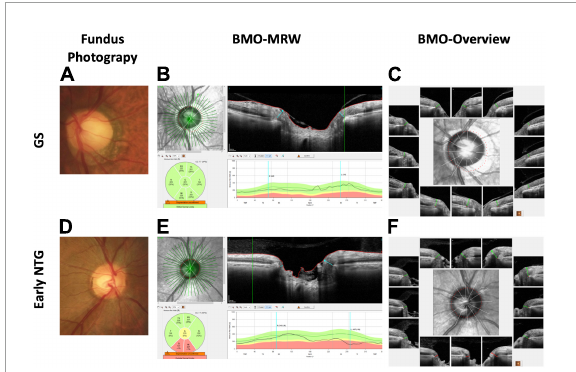
FIGURE1 Representative cases of GS and early NTG. (A) The optic disc of a 70-year-old male GS patient with a spherical equivalent of − 1.0 diopter from fundus photography is shown. Note that the optic disc cup seems big based on the clinical disc margin. (B) The BMO-MRW map shows normal color code classification in this GS case. The BMO-MRW is the minimal distance between the inner opening of the BMO and the internal limiting membrane. (C) BMO Overview, which is BMO-based disc photography from spectral-domain OCT. It shows the BMO-based disc margin (dotted red line) at the center with 12 cuts around the optic disc, demonstrating each BMO and BMO-MRW at each site. Note that the BMO-based disc margin includes part of the PPA, showing that the optic disc cup does not seem as big based on the BMO margin compared to the clinical disc margin. (D) Optic disc of a 56-year-old male NTG patient with a spherical equivalent of +1.0 diopter from fundus photography is shown. Note the thinning of the inferotemporal neuroretinal rim of the optic disc. (E) . BMO-MRW map shows abnormal color code classification (red) at the inferotemporal and inferonasal sector in this NTG case. (F) BMO Overview shows a shorter BMO-MRW (red lines) at the inferior three cuts compared to the other regions with normal lengths (green lines). Note that the optic disc cup seems markedly enlarged at the inferotemporal region based on the BMO-based disc margin (dotted red line). GS: glaucoma suspect; NTG: normal-tension glaucoma; BMO-MRW: Bruch’s membrane